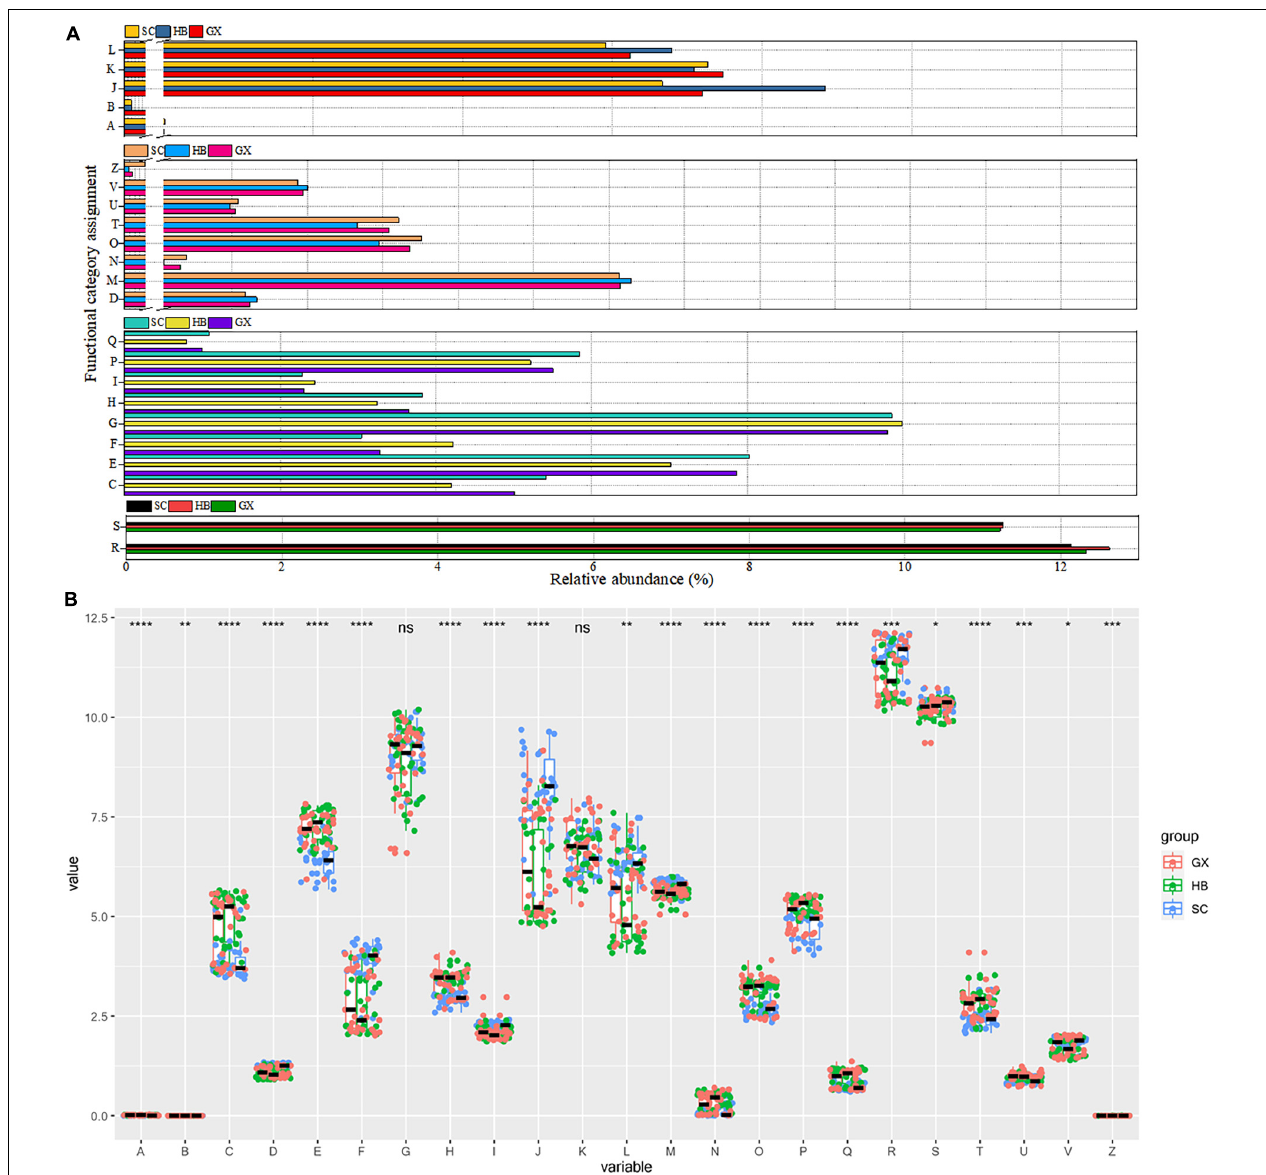
FIGURE 6 | Overview of the relative abundance of the bacterial profile (A) . Correlation analysis of COG functional categories of rice wine koji samples between regions (B) . COG functional categories codes are as follows: A = RNA processing and modification; B = chromatin structure and dynamics; C = energy production and conversion; D = cell cycle control, cell division, chromosome partitioning; E = amino acid transport and metabolism; F = nucleotide transport and metabolism; G = carbohydrate transport and metabolism; H = coenzyme transport and metabolism; I = lipid transport and metabolism; J = translation, ribosomal structure, and biogenesis; K = transcription; L = replication, recombination, and repair; M = cell wall/membrane/envelope biogenesis; N = cell motility; O = posttranslational modification, protein turnover, chaperones; P = inorganic ion transport and metabolism; Q = secondary metabolites biosynthesis, transport and catabolism; R = general function prediction only; S = function unknown; T = signal transduction mechanisms; U = intracellular trafficking, secretion, and vesicular transport; V = defense mechanisms; Z = cytoskeleton. Significant differences are represented by ****( p < 0.0001), ***(0.0001 ≤ p < 0.001), **(0.001 ≤ p < 0.01), *(0.01 ≤ p < 0.05), and ns ( p ≥